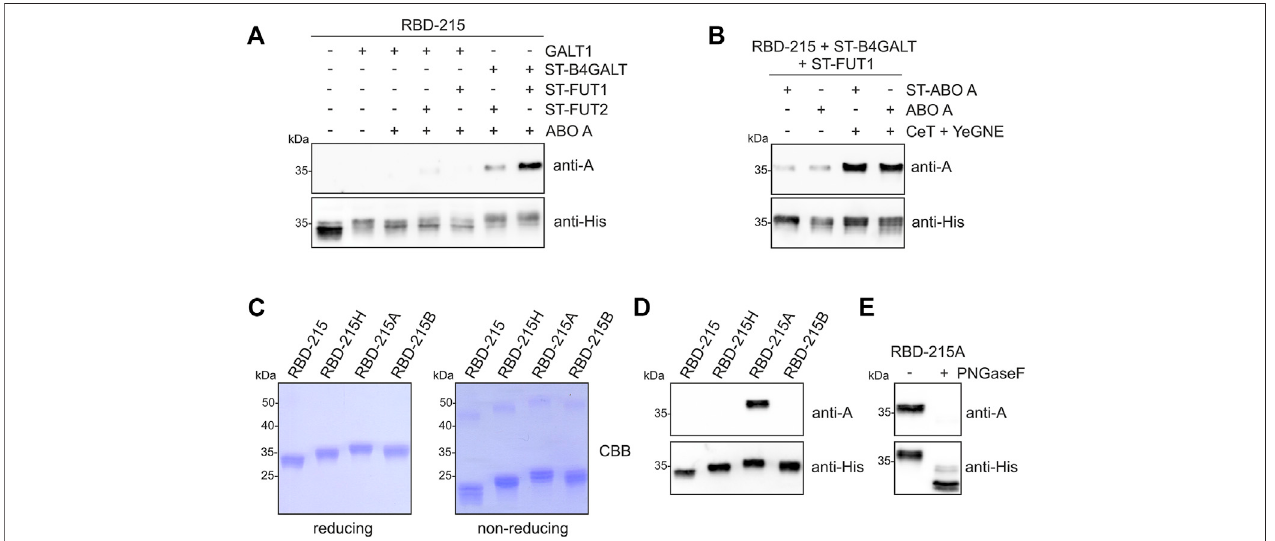
FIGURE 3 | Plant-based production of RBD-215 with type 2 blood group A antigens. (A) RBD-215 was transiently expressed in the glycoengineered N. benthamiana line Δ XT/FT together with the indicated glycosyltransferases. 3 days-after in fi ltration, RBD-215 was puri fi ed from crude protein extracts using magnetic beads and subjected to SDS-PAGE, and immunoblotting with anti-blood group A (3-3A) or anti-His-tag antibodies. (B) Co-expression of Y. enterocolitica UDP-GlcNAc 4-epimerase(YeGNE) and C. elegans UDP-GlcNAc/UDP-GalNAc transporter(CeT) improvestheformationofblood groupAantigens. (C) RBD-215variants were IMAC-puri fi ed from the apoplastic fl uid of in fi ltrated line Δ XT/FT and subjected to SDS-PAGE under reducing and non-reducing conditions. (D) SDS-PAGE and immunoblotting of IMAC-puri fi ed RBD-215 variants with anti-blood group A (3-3A) or anti-His-tag antibodies. (E) PNGase F digestion of IMAC-puri fi ed